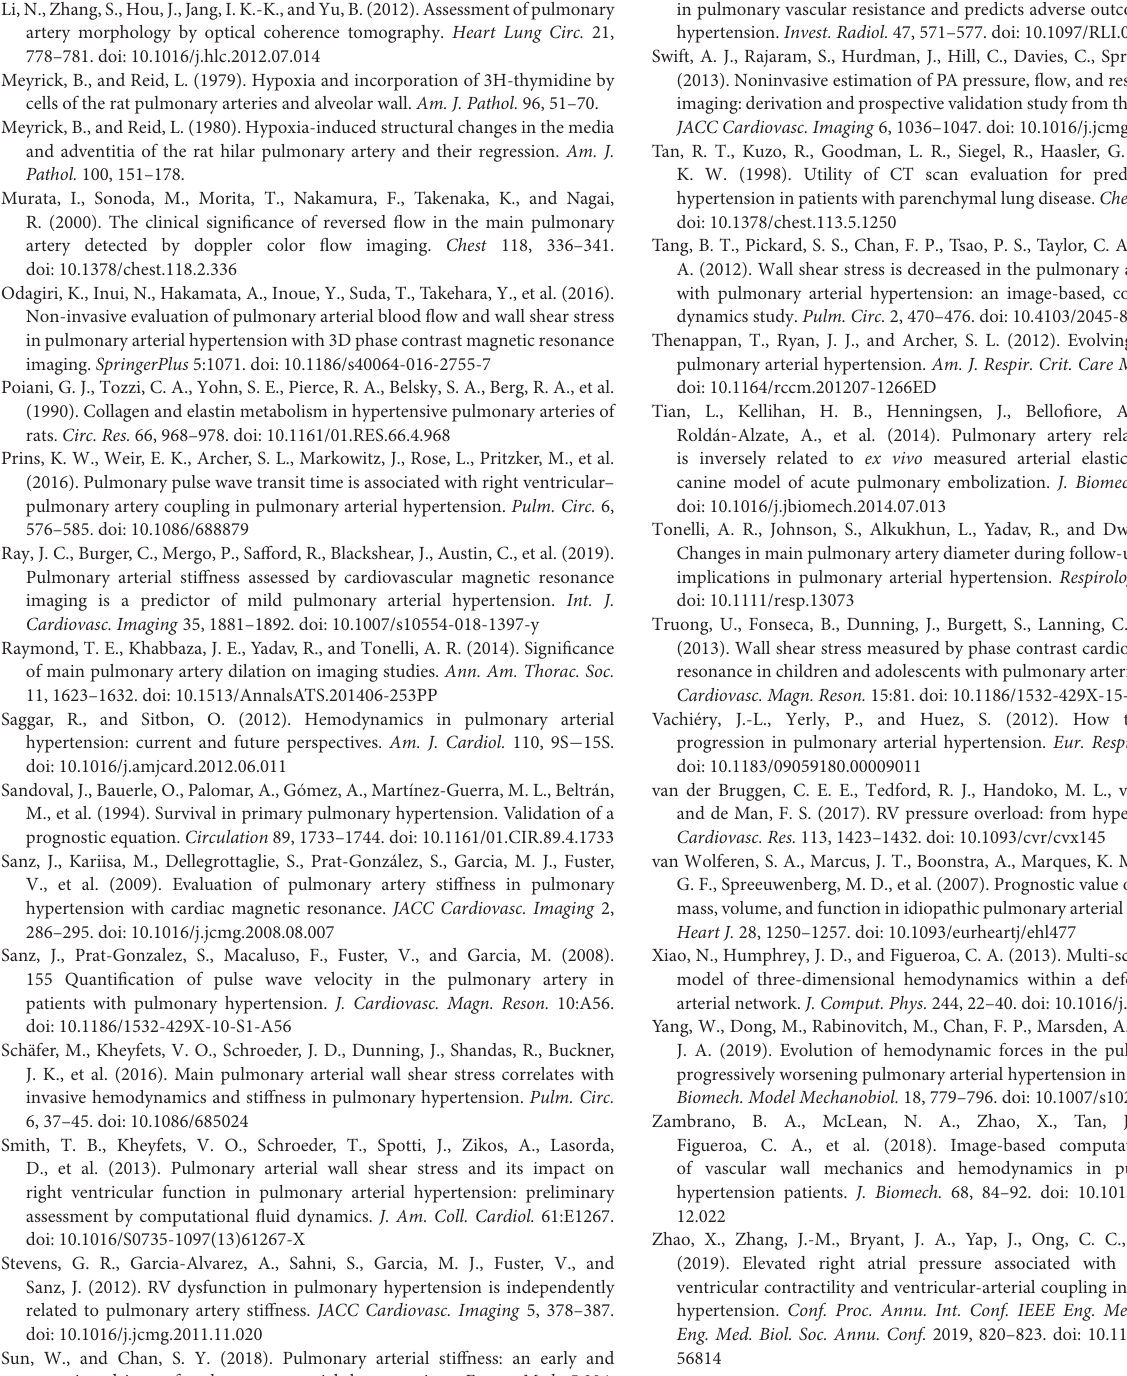
Figueroa, C. A., et al. (2018). Image-based computational assessment of vascular wall mechanics and hemodynamics in pulmonary arterial